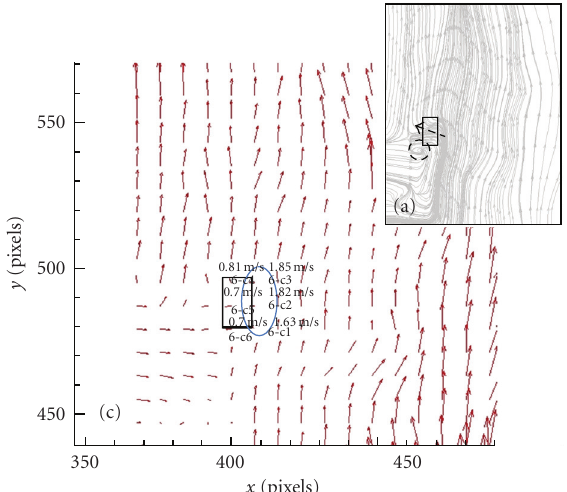
Figure 6: (a) Streamlines passing through the flame edge of case 3. (c) Velocity variation at the flame edge of case 3. The velocities of the six points in the rectangle are 1.06 m/s, 0.81 m/s, 0.92 m/s, 0.7m/s, 0.81 m/s, and 0.7 m/s (ordered by left to right, top down). The velocities of the three points of 6-c1, 6-c2, and 6-c3 are 1.63 m/s, 1.82m/s, and